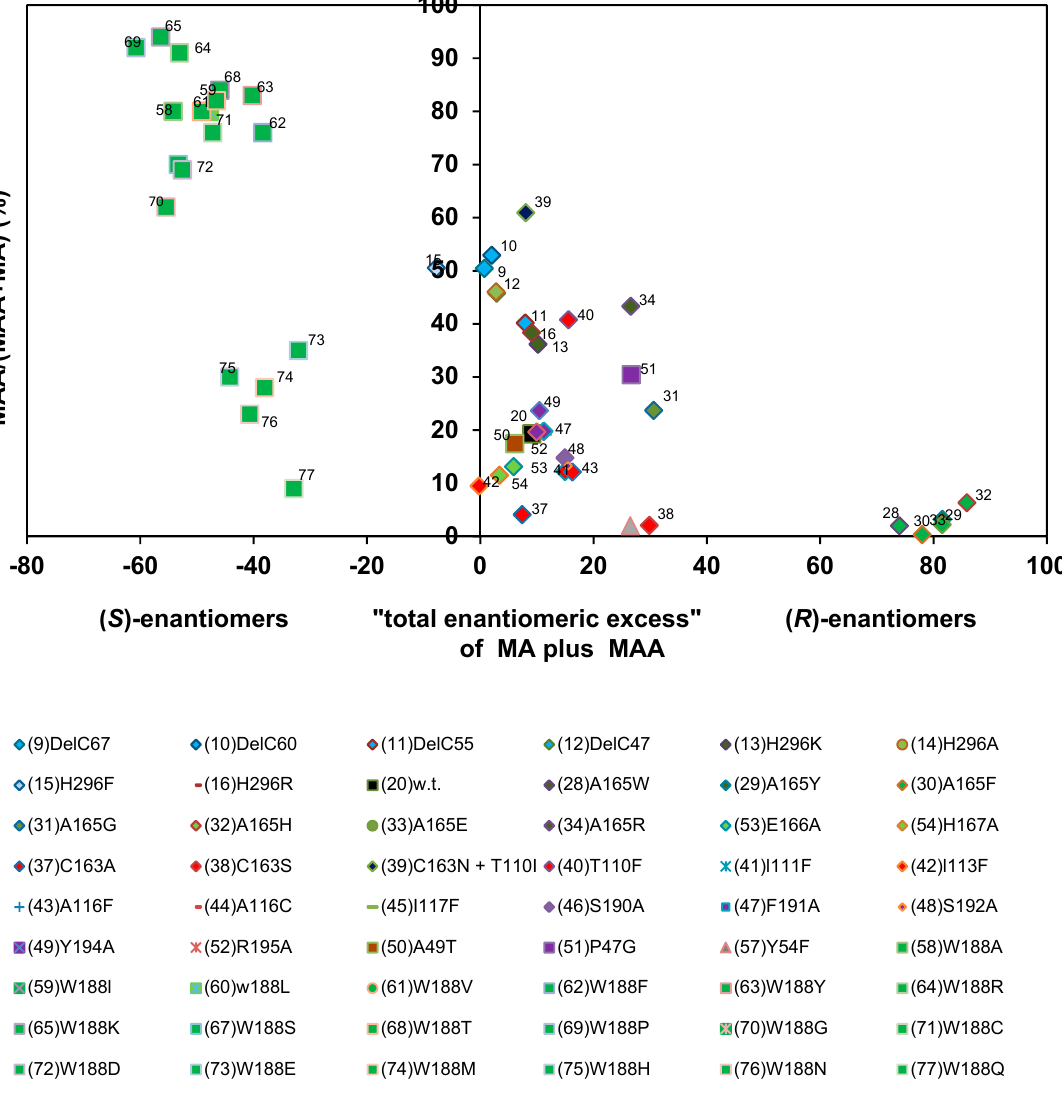
Figure 13. Correlation of the relative amounts of mandelamide formed and the “total enantiomeric excess” of the products formed during the turn-over of ( R , S )-mandelonitrile. The data were taken from previous publications (see Figure 6) and the calculations performed as described in the text and exemplified in Table 1.